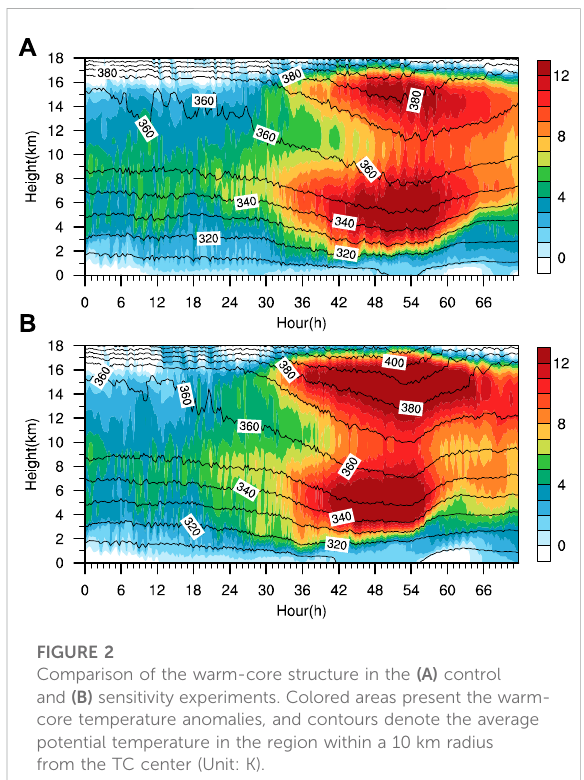
Comparison of the warm-core structure in the (A) control and (B) sensitivity experiments. Colored areas present the warm- core temperature anomalies, and contours denote the average potential temperature in the region within a 10 km radius from the TC center (Unit: